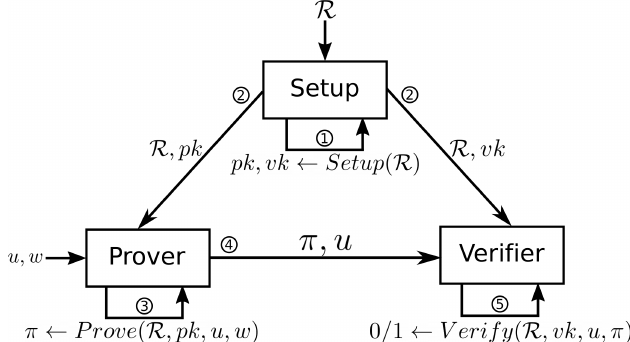
Figure 1. Zero-Knowledge Proof